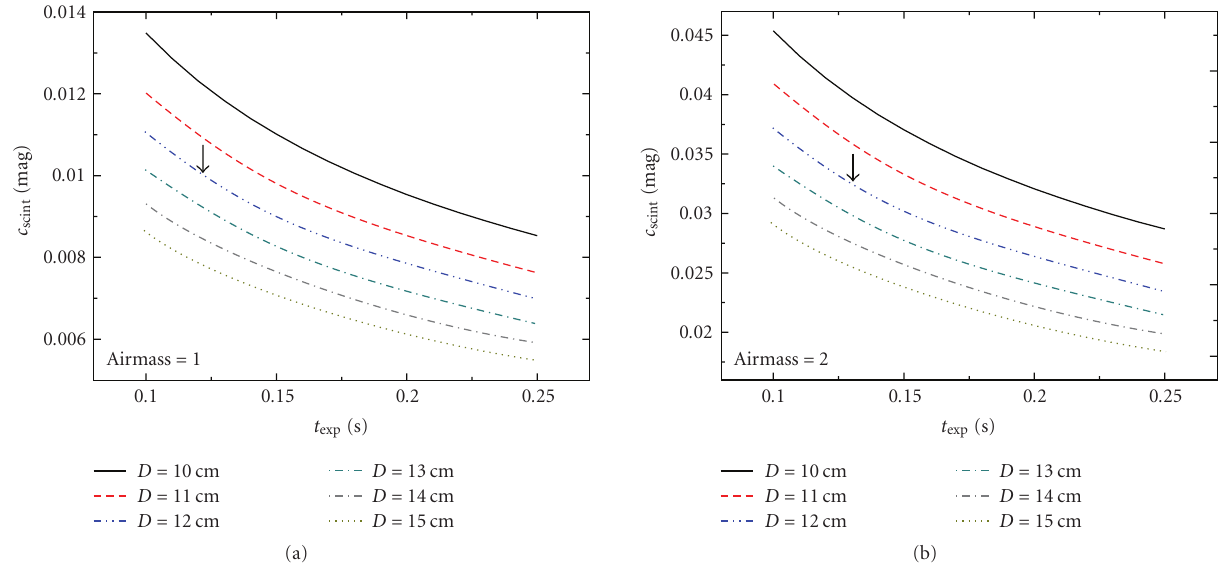
Figure 2: c scint versus short exposure times t exp < 0.25 seconds for di ff erent size of telescopes (10cm ≤ D ≤ 15cm) at a fixed values of airmass: X = 1 (a) and X = 2 (b). The arrows indicate the typical scintillation noise in TORTORA